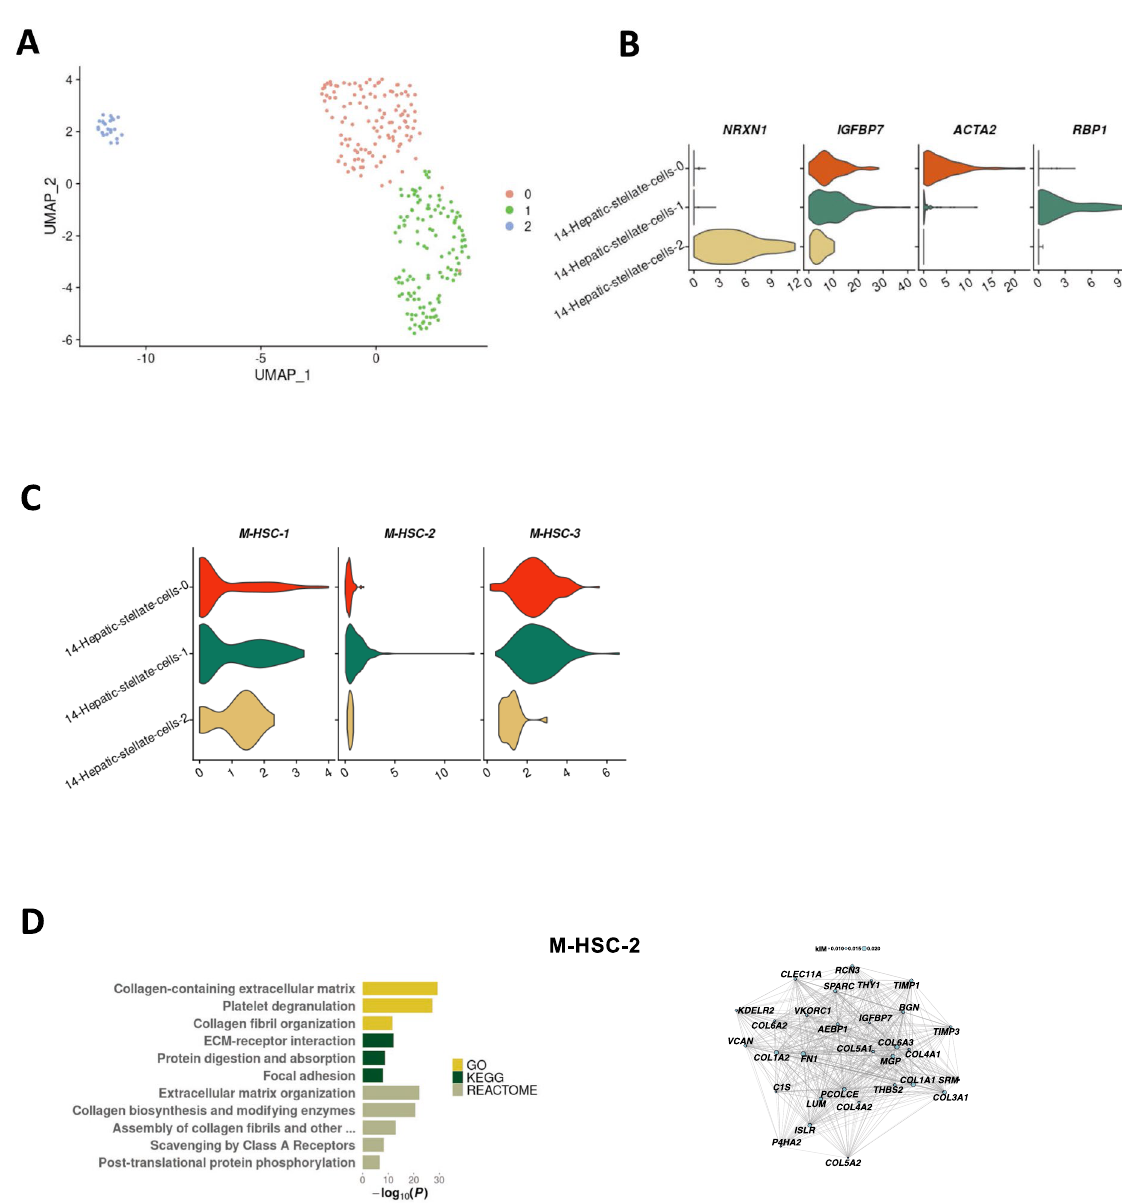
Figure 5. Activated human hepatic stellate cells are divided in two functionally specific subpopulations. ( A ) UMAP projection of the three hepatic stellate cell clusters. ( B ) Violin plots of normalised and batch-corrected expression of hepatic stellate cell marker genes. ( C ) Violin plots of the activity of hepatic stellate cell modules. ( D ) M-HSC-2, of which the 30 most central genes are seen in the network diagram. In the network diagram, node sizes represent gene centrality in the module (‘kIM’), and edge widths represent the strength of gene–gene co-expression. For the bar plot, gene sets from the Gene Ontology (GO), Kyoto Encyclopaedia of Genes and Genomes (KEGG) and Reactome databases were queried. Only significant results were plotted ( P <